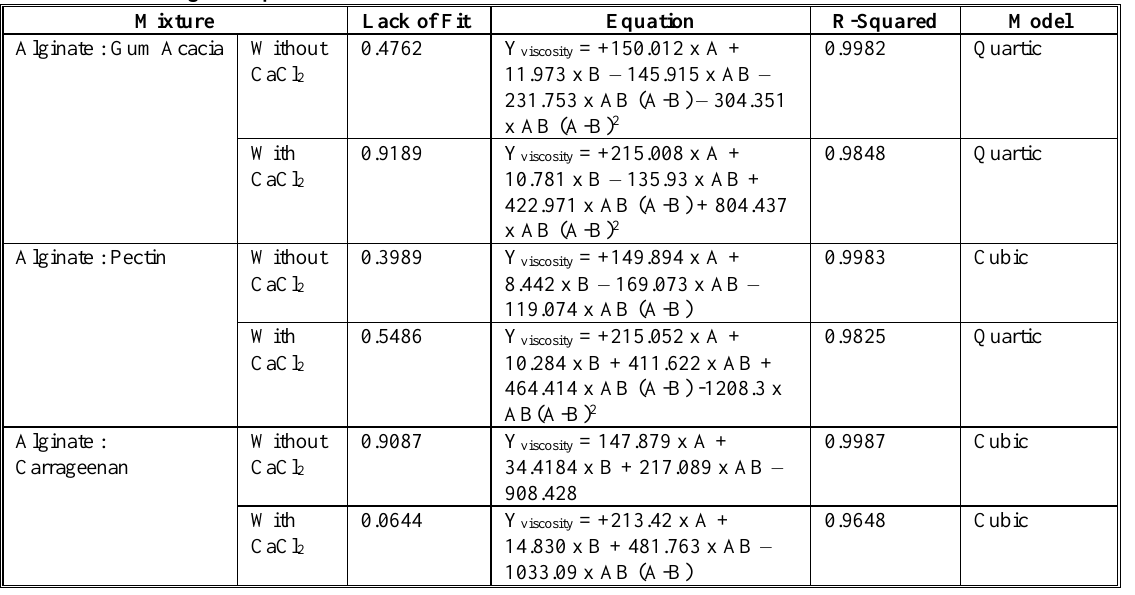
Table 2. Model design of